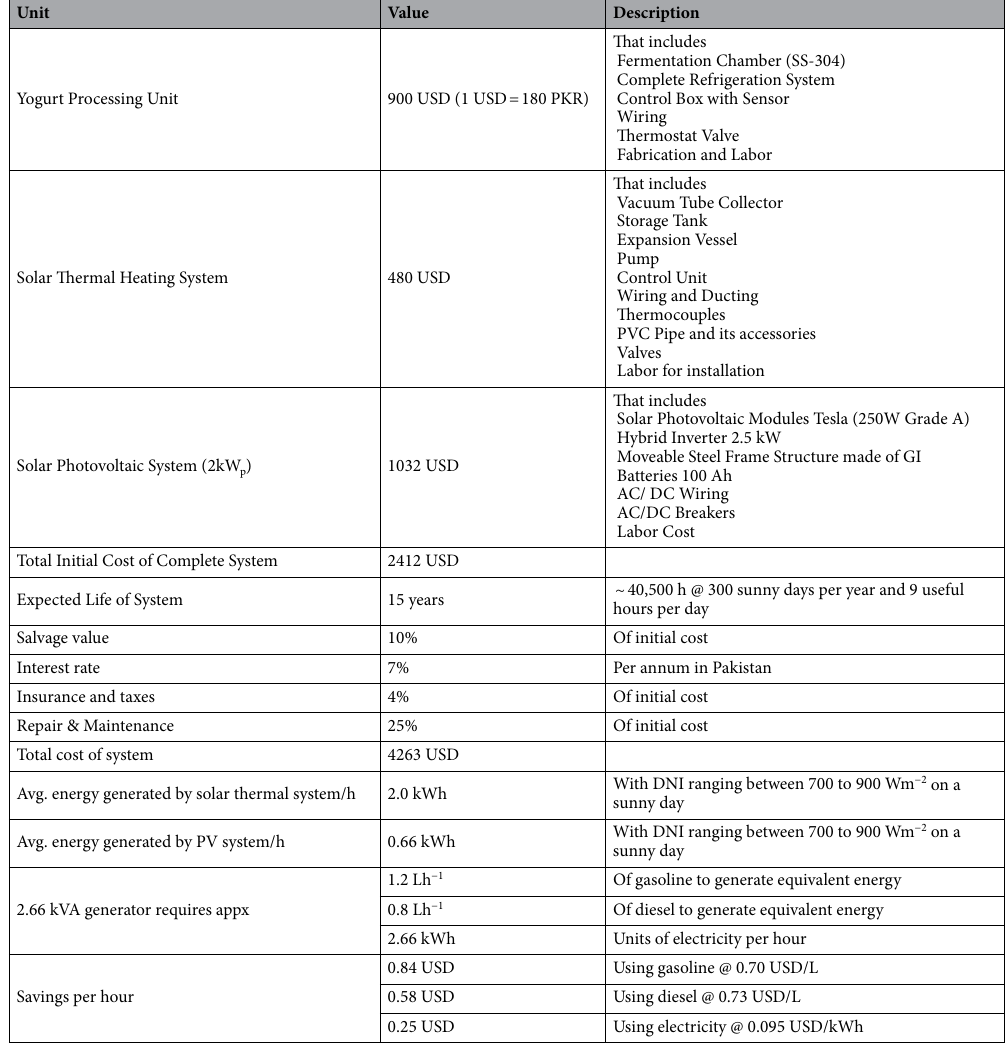
Table 5. Available data for economic